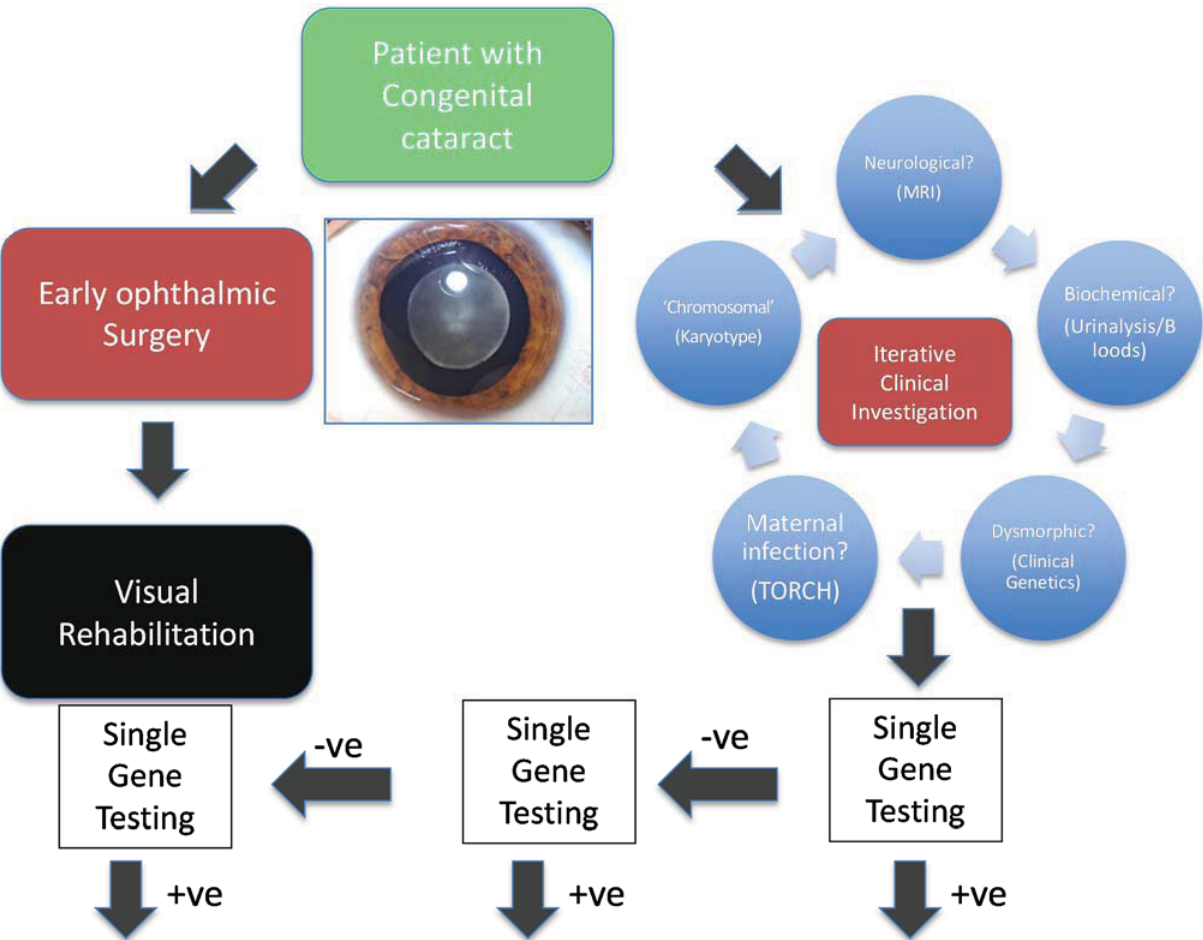
Figure 1. Classical clinical hypothesis-driven diagnostic approach. Traditional investigation of genetically and clinically heterogeneous conditions, such as congenital cataract, require an inefficient and iterative process based upon the development and testing of multiple clinical hypotheses, which leads to testing of many genes in